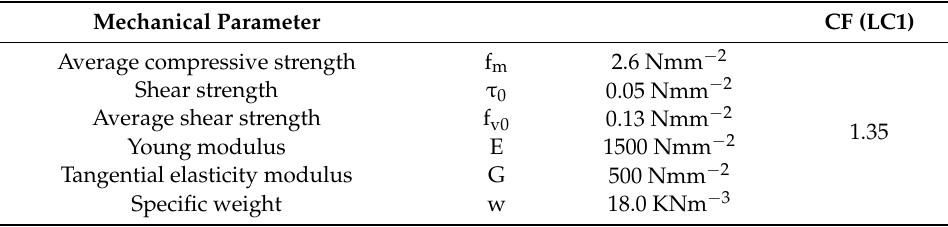
Table 1. Basic mechanical properties of masonry walls used for inspected SUs [27].